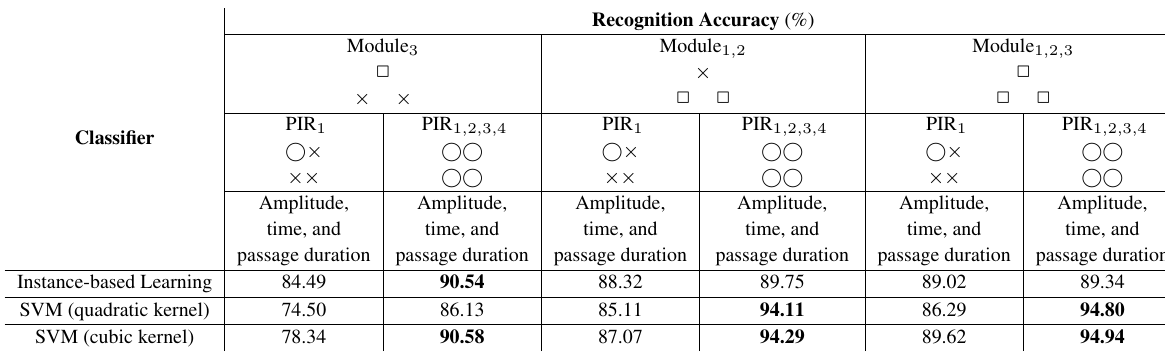
Table 11. Comparison of the recognition accuracy (%) of classifying walking speed levels based on the reduced feature set with respect to the modules and features (amplitude and time to peaks and passage